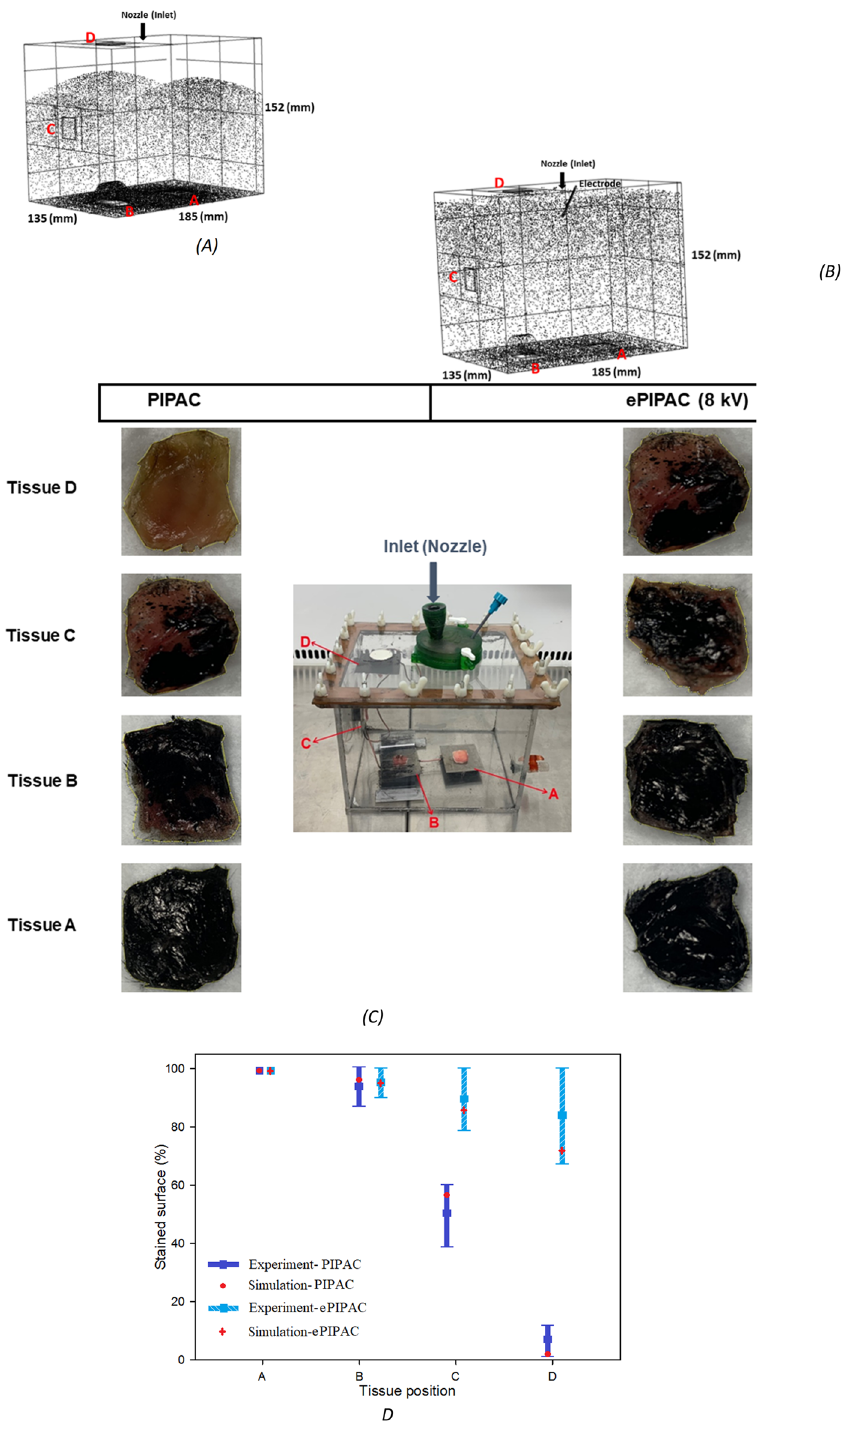
Figure 6. Aerosol droplet distribution patterns in the box model obtained using CFD simulations for ( A ) PIPAC and ( B ) ePIPAC. ( C ) typical aerosolized ink deposition patterns on the tissue samples located at different locations in the in vitro box model, with and without application of electrostatic precipitation. ( D ), comparison between in vitro results and CFD simulation of aerosol distribution at positions A–D. In vitro experiments were performed in triplicate; error bars represent mean